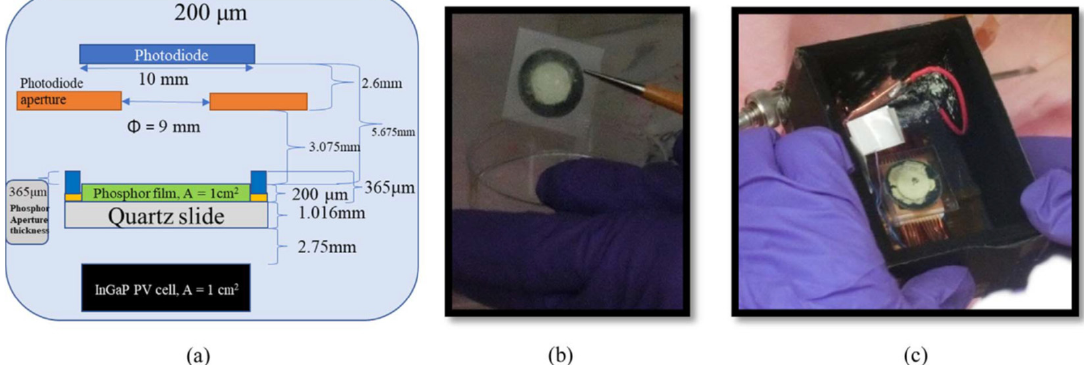
Figure 9. Illustrations and images of the volumetric β‐ PV cell experiment: 3D configuration for 200 μ m phosphor sample ( a ), 63NiCl 2 ‐ loaded phosphor sample after solution integration and drying procedure ( b ) and sample placed on top of InGaP PV cell in a light ‐ tight enclosure ( c ). Copyright permission from [130].